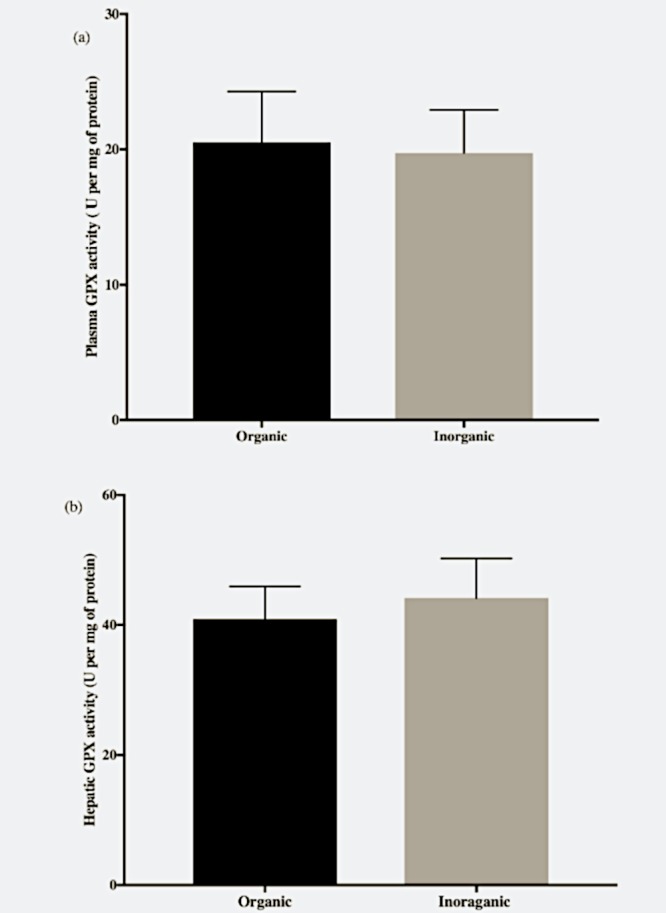
Glutathione peroxidase activity of Nile tilapia, Oreochromis niloticus, in (a) plasma and (b) liver supplemented with seleno-L-methionine (organic) and sodium selenite (inorganic) Se in basal diet.Unit (U) is nano moles of NADPH oxidized per milligram of total protein per minute. There were no significant differences (p>0.05) in hepatic and plasma activity indicating both forms of Se were sufficient to meet tissue need for maximizing GPX activity.